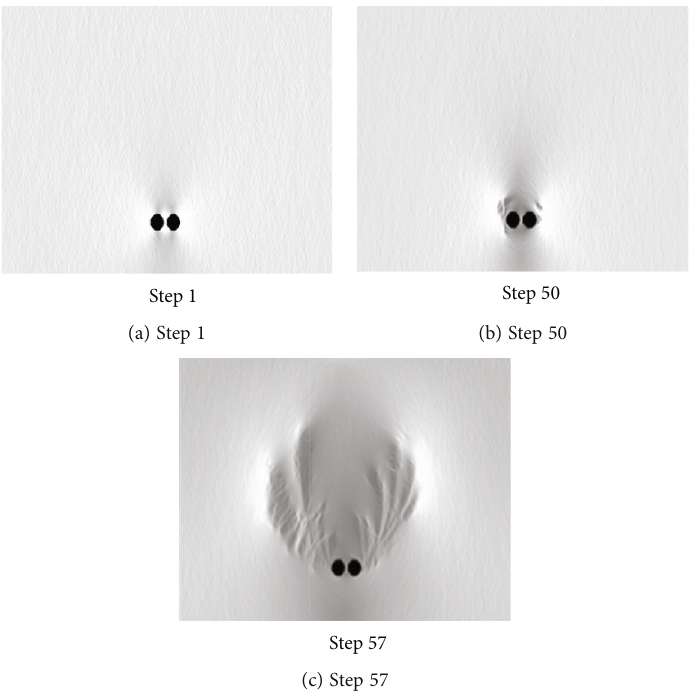
Figure 18: Maximum principal stress evolution 350-mm double boreholes.